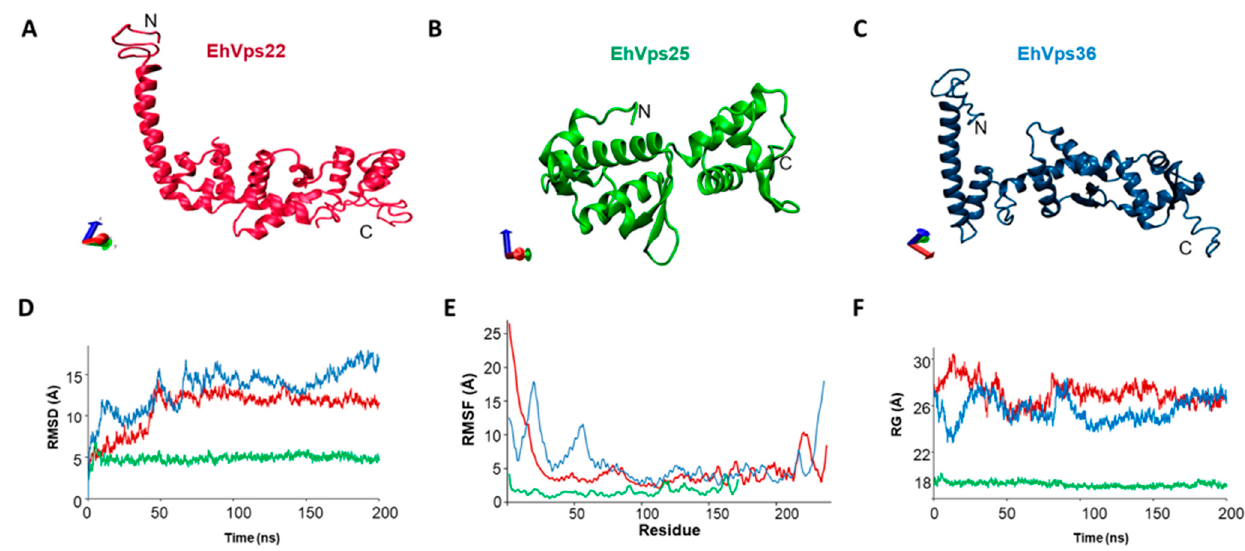
Figure 2. 3D structures of EhVps22, EhVps25, and EhVps36 and MD simulation. ( A – C ) 3D model of EhVps22, EhVps25, and EhVps36. ( D ) RMSD. ( E ) RMSF. ( F ) Rg: Radius.